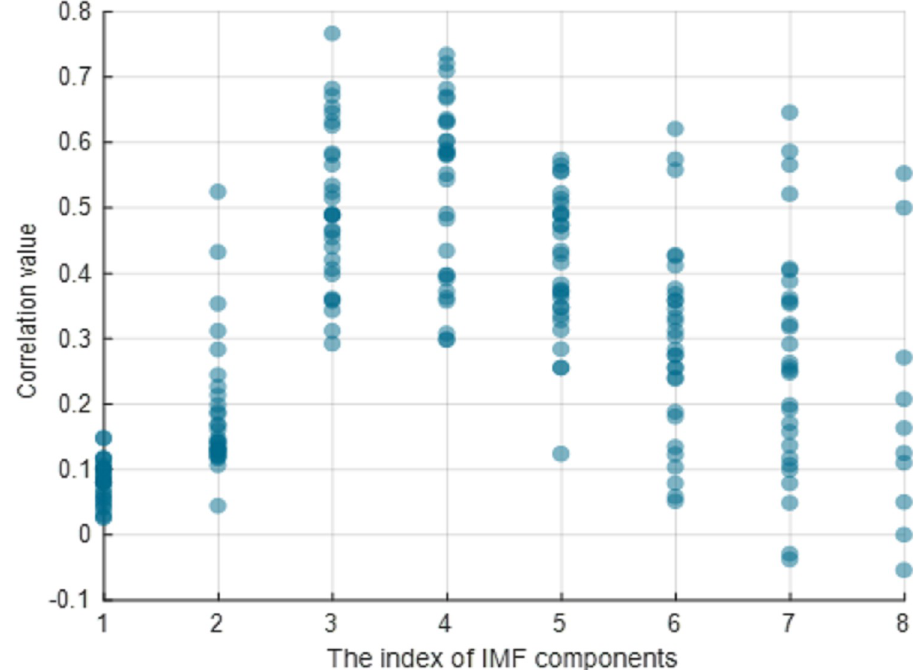
Fig 7. Results of the correlation between sets of IMFs and raw sEMG signals. The horizontal and vertical axes present the index of each IMF in a set of IMFs and the correlation value, respectively.